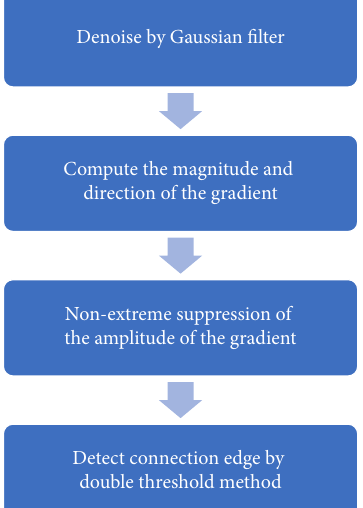
Figure 4: Flow chart of edge gradient detection